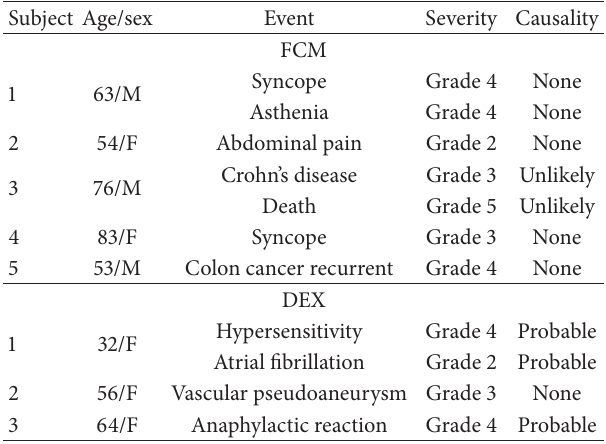
Table 3: Subjects who experienced serious adverse events. Table 4: Patients who experienced adverse events that led to premature discontinuation from the